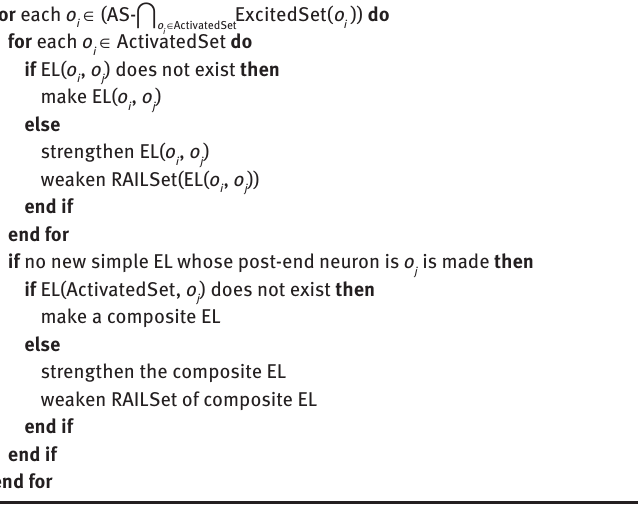
Algorithm 3: Neural Network Adjusting for Case